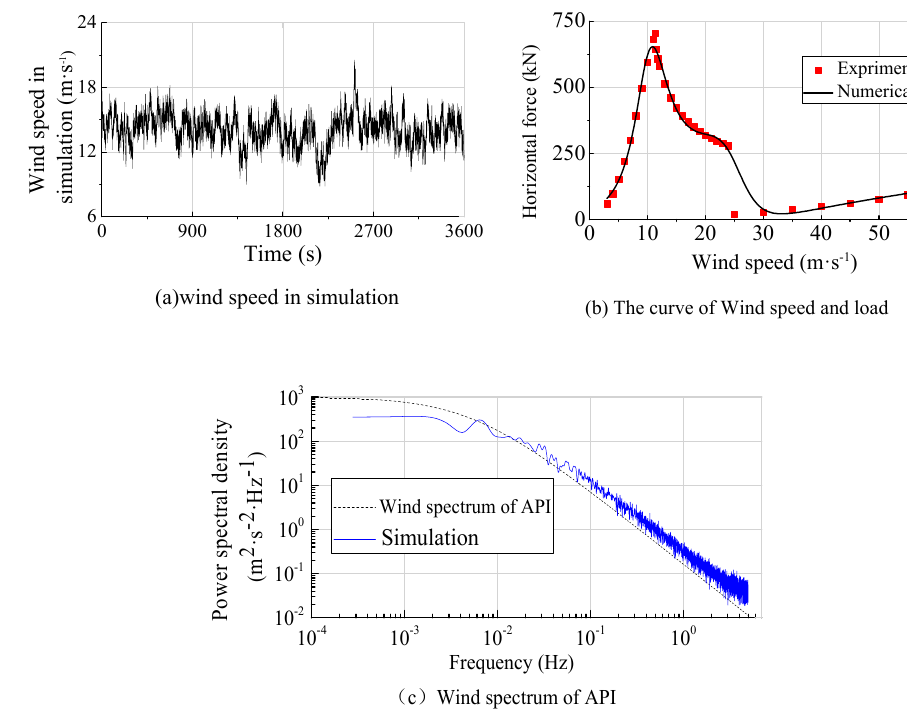
Figure 11. Relationship between horizontal wind load and wind speed and API wind in Simulink.